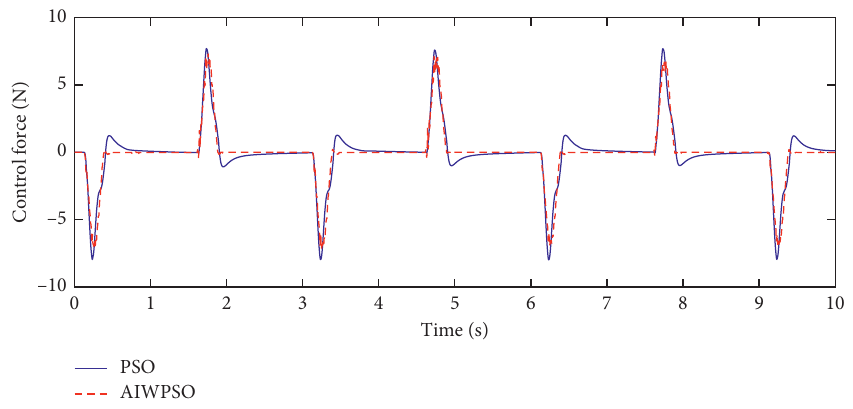
Figure 20: Actuator force for a trapezoidal profile.